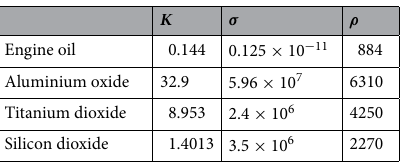
Table 1. Thermal properties of hybrid nanoparticleswith base